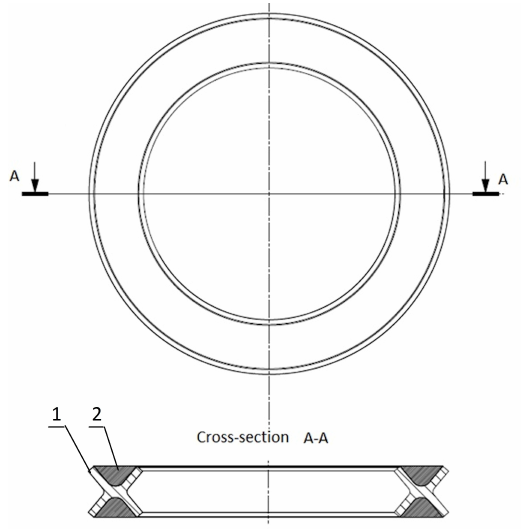
Figure 1: The semimetal gasket with an elastic metal core, 1 - metal core, 2 - flexible